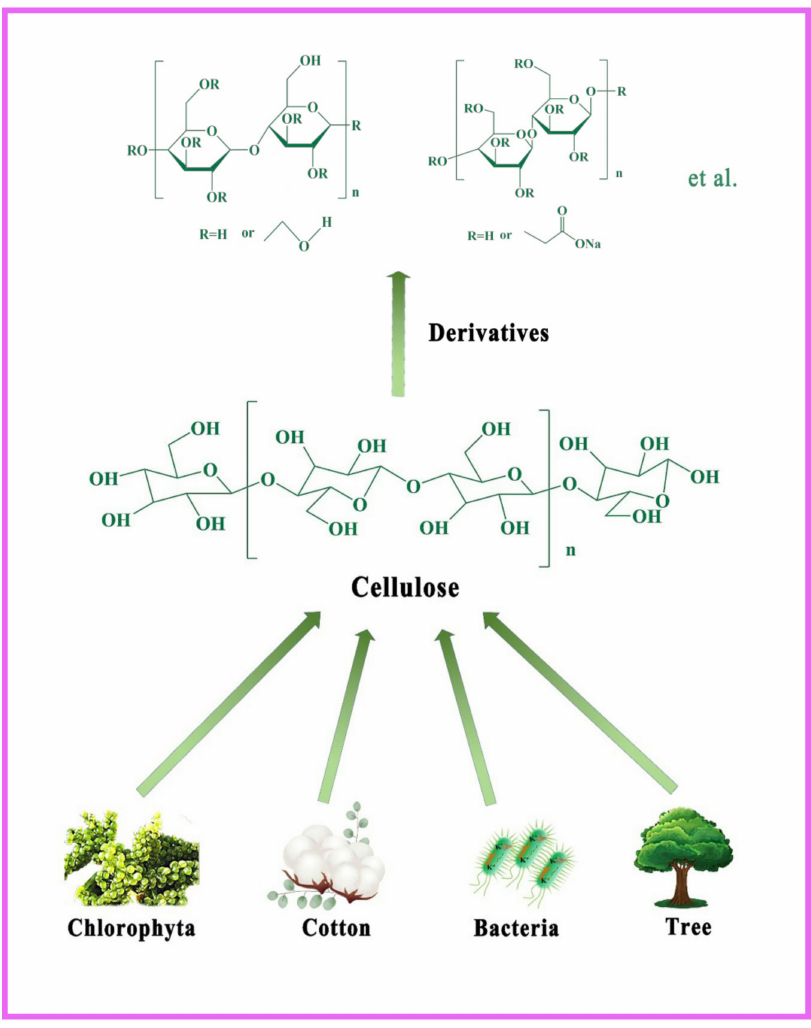
Figure 1. Molecular structure of cellulose and its origin in